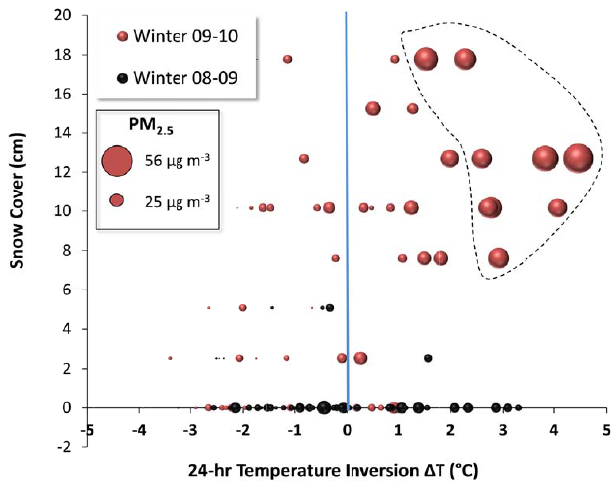
Fig. 3. Average 24-h PM 2 . 5 mass concentration (bubble diameter) by beta attenuation monitor (BAM) as a function of temperature in- version ( 1T = T Galena − T Rail ) and snow cover. The largest bubble corresponds to 56.1µgm − 3 of PM 2 . 5 . The dashed circle encloses all nine days that exceeded the USEPA 24-h PM 2 . 5 National Ambi- ent Air Quality Standard (NAAQS) of 35µgm − 3